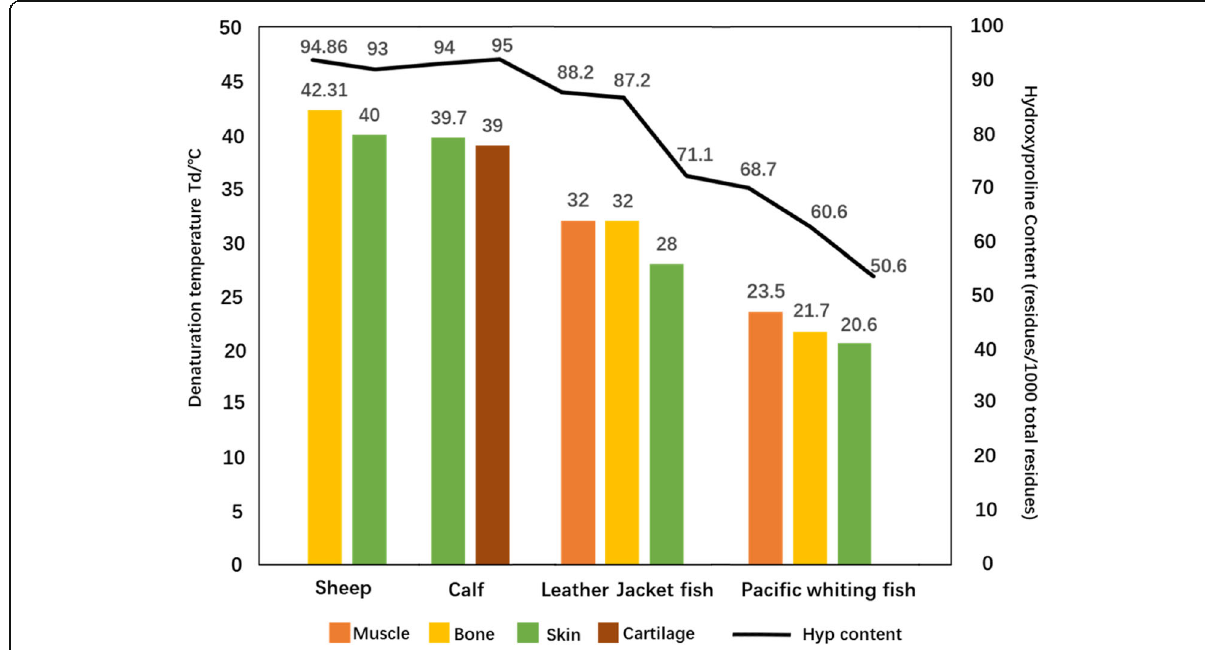
Fig. 3 Denaturation Temperature (Td/°C) and Hydroxyproline Content (residues/1000 total residues) of collagen from varying tissues. Sheep [28, 78], Calf [66, 76], Leather Jacket fish [96] and Pacific whiting fish